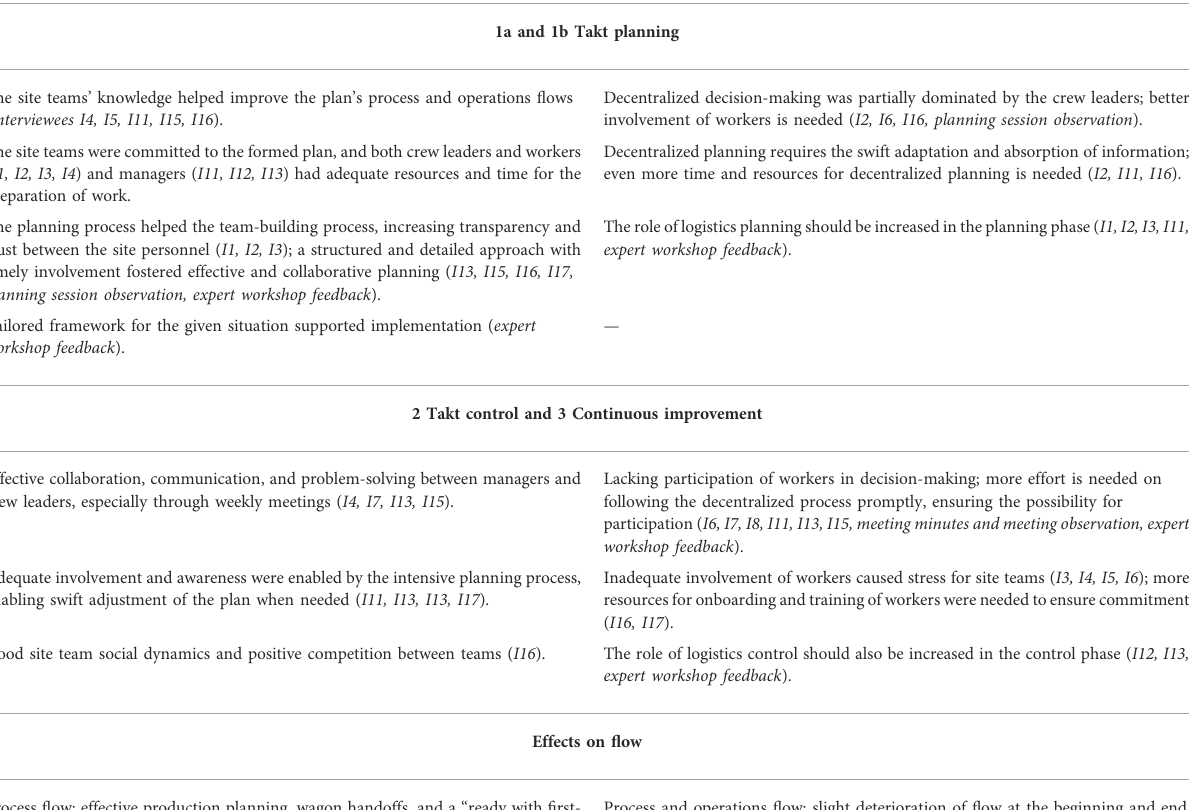
TABLE 3 Summary of the implementation